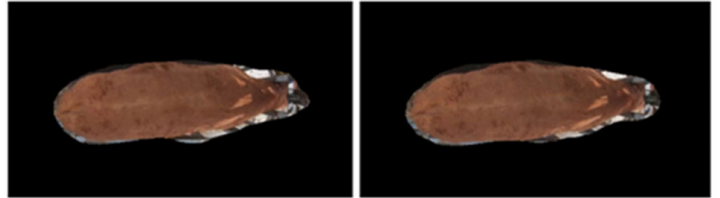
Figure 10. Segmentation results of the WSS